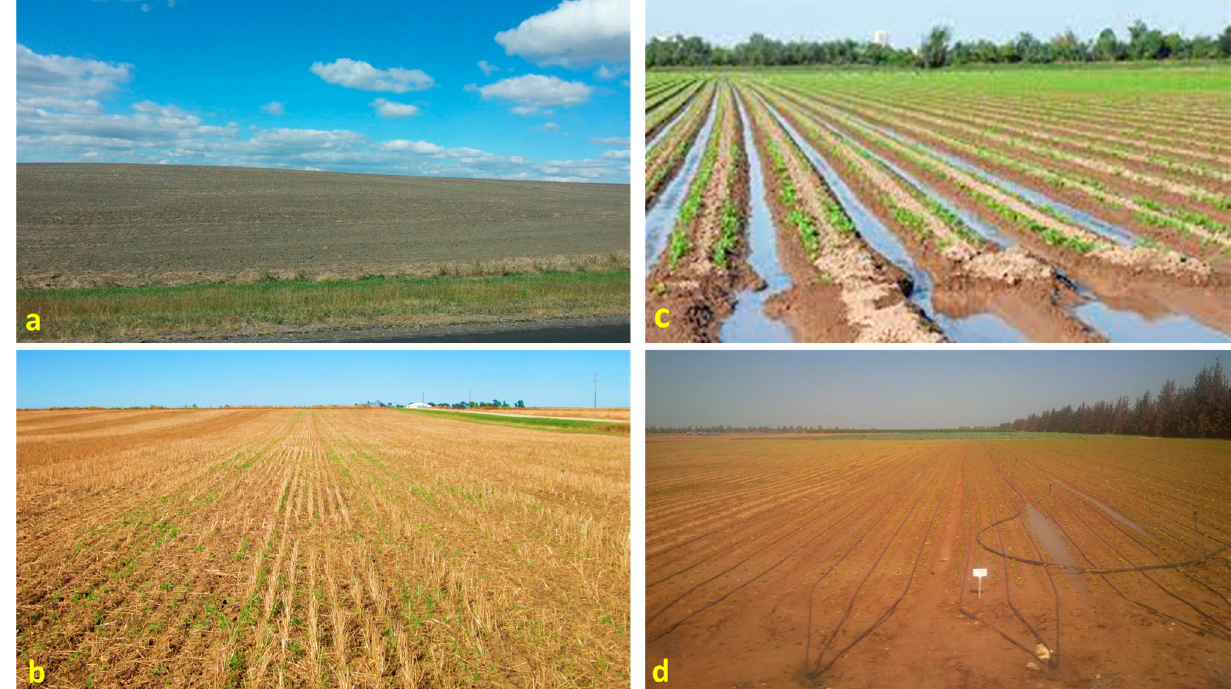
Figure 6. Visual comparison of the semi-arid agroecosystems captured by the model and simulation experiments: (panel a ) conventional tillage without crop residue, clay and clay loam soils; (panel b ) similar soil pedon characteristics and crop production system as above (panel a ) except under a no-till practice with high crop residue; (panel c ) flood irrigation via furrows; and (panel d ) similar soil pedon characteristics and crop production system as above (panel c ) except under a drip irrigation practice. [Photograph attributions: panels a , b , d , author; panel c , Texas Water Development Board.]